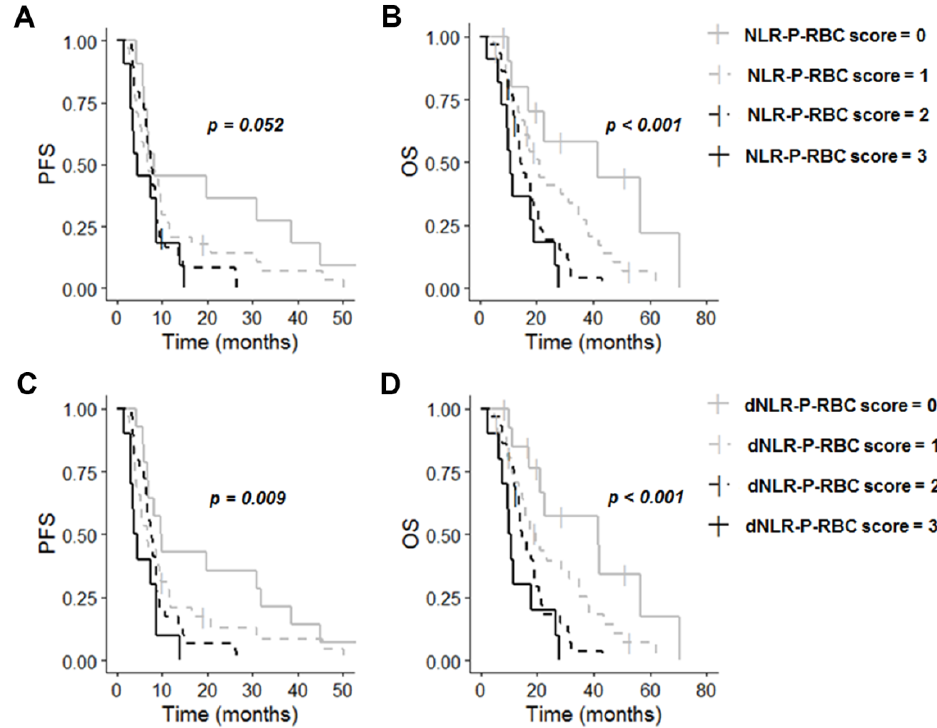
Figure 2. Kaplan–Meier curves for survival stratified by NLR-P-RBC score (( A ) PFS; ( B ) OS) and dNLR-P-RBC score (( C ) PFS; ( D ) OS). Abbreviations: dNLR-P-RBC, derived neutro- lymphocyte ratio-platelet count-red blood cell count; NLR-P-RBC, neutrophil-to-lymphocyte ratio- phil-to-lymphocyte ratio-platelet count-red blood cell count; NLR-P-RBC, neutro- platelet count-red blood cell count; OS, overall survival; PFS, progression-free phil-to-lymphocyte ratio-platelet count-red blood cell count; OS, overall survival; PFS, progres- sion-free survival.